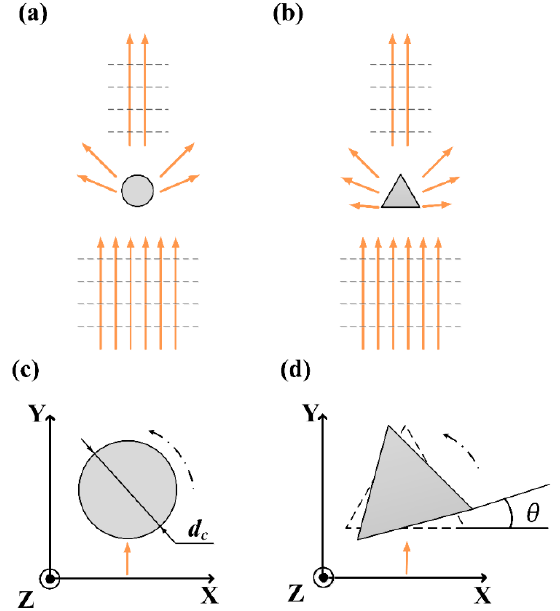
Figure 6. The models of fibers in ( a , c ) circular and ( b , d ) triangular shapes are presented. The light propagation is sketched in ( a , b ), while the coordinate is defined in ( c , d ). The yellow arrows denote the propagation light rays, which inject onto the fiber and are then absorbed, scattered or transmitted forward. The black dashed lines indicated the plane-wave field.